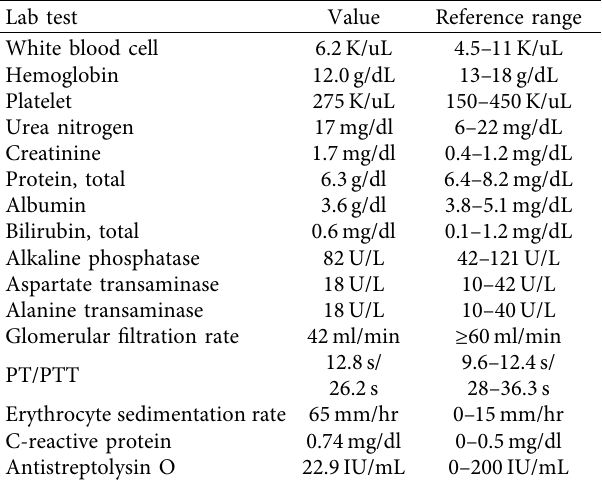
Table 1: Laboratory workup. Significant abnormal values include elevation in creatinine consistent with chronic kidney disease and elevated inflammatory markers.